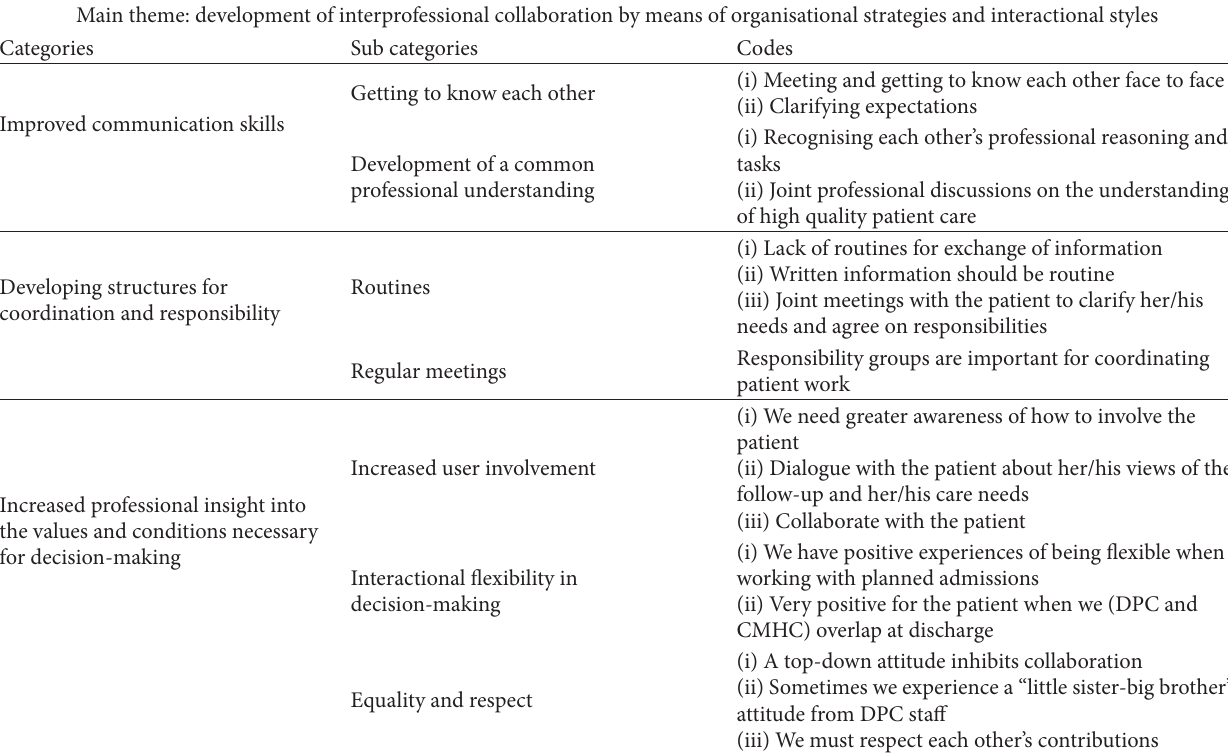
Table 1: Summary of the findings: main theme, categories, subcategories, and